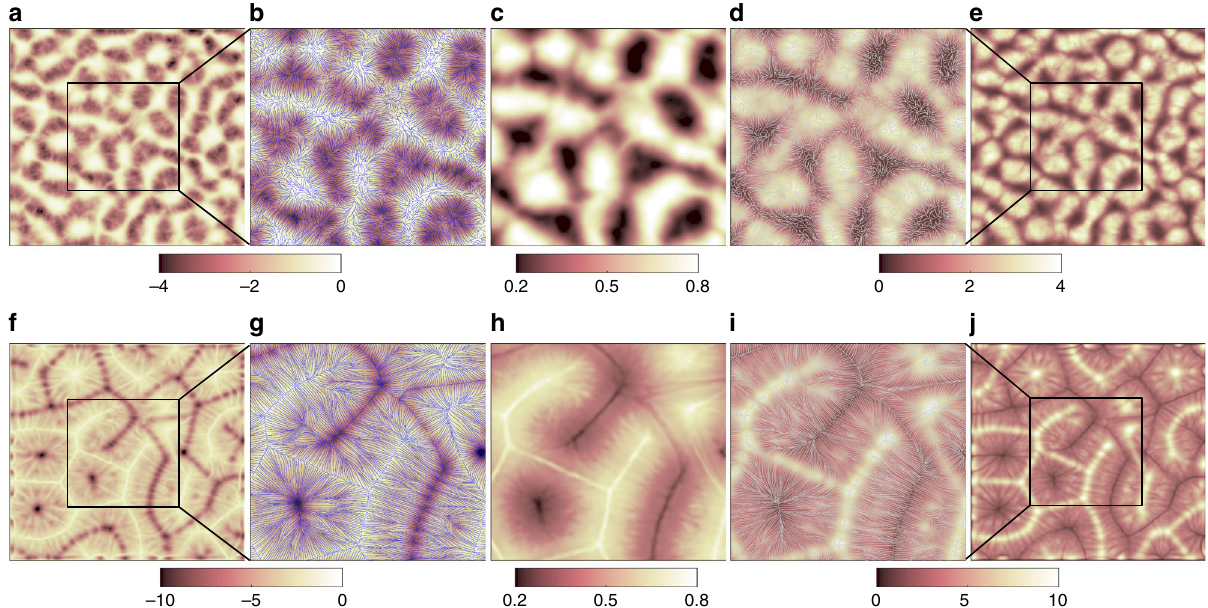
Fig. 7 Temperature fi eld structure averaged over time τ in boundary layer and midplane. The data in top row ( a – e ) of the fi gure are obtained for the case of Pr = 0.005, the data in bottom row ( f – j ) for Pr = 7, both at Ra = 10 5 . a , f Contours of 〈 ∂ T / ∂ z 〉 τ at z = 0. e , j Contours of − 〈 ∂ T / ∂ z 〉 τ at z = 1. Boxes in these plots indicate the magni fi cation region which is a quarter of the full cross section. b , d and g , i are magni fi cations of a , e and f , j , respectively. In addition, we display fi eld lines of the corresponding time-averaged skin friction fi eld 〈 s 〉 τ in blue (white) for the bottom (top) plate. c , h show the corresponding time-averaged temperature fi eld Θ in the midplane at z = 1/2. Color bars are added to the corresponding fi gures. The size of b – d and g – i is the